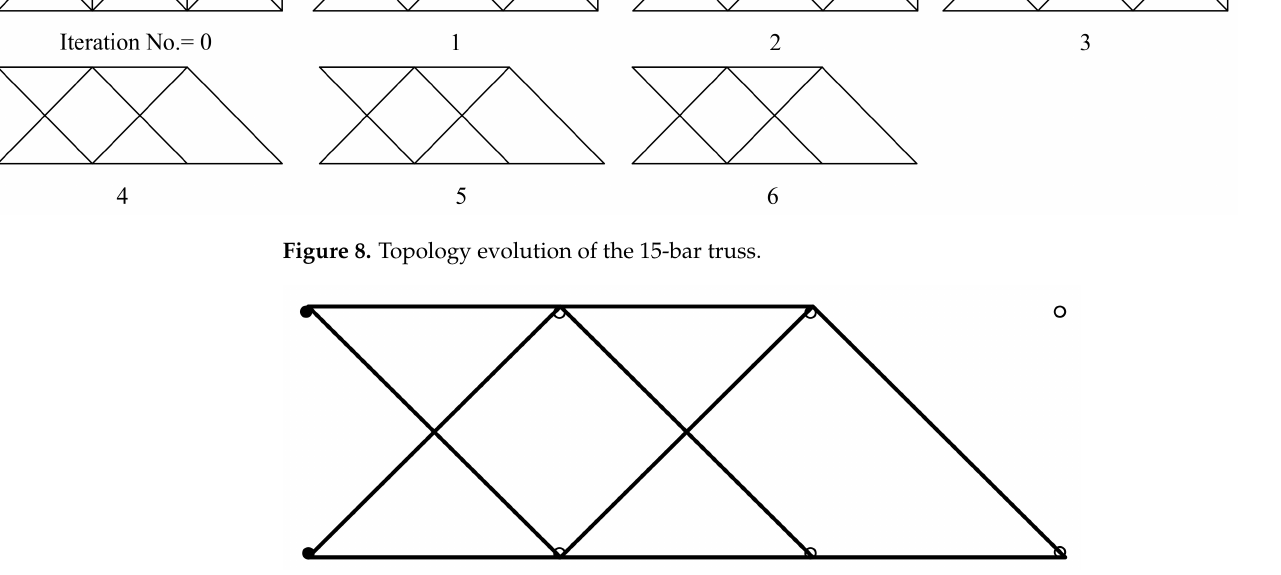
Figure 9. Optimization results in this paper.